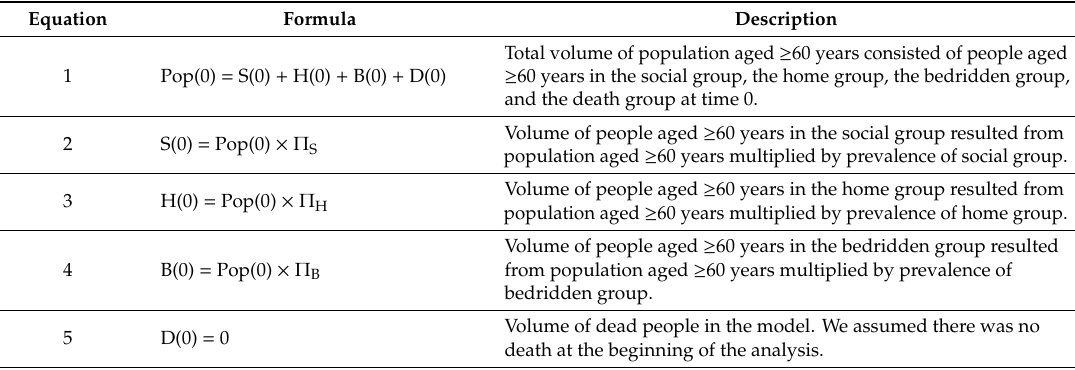
Table 3. Summary of the equations used to estimate the volume of population at the start of the analysis (initial